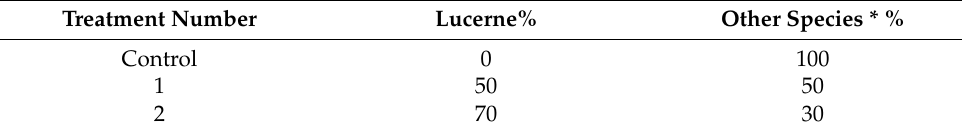
Table 4. Botanical composition of lucerne treatments in grazing